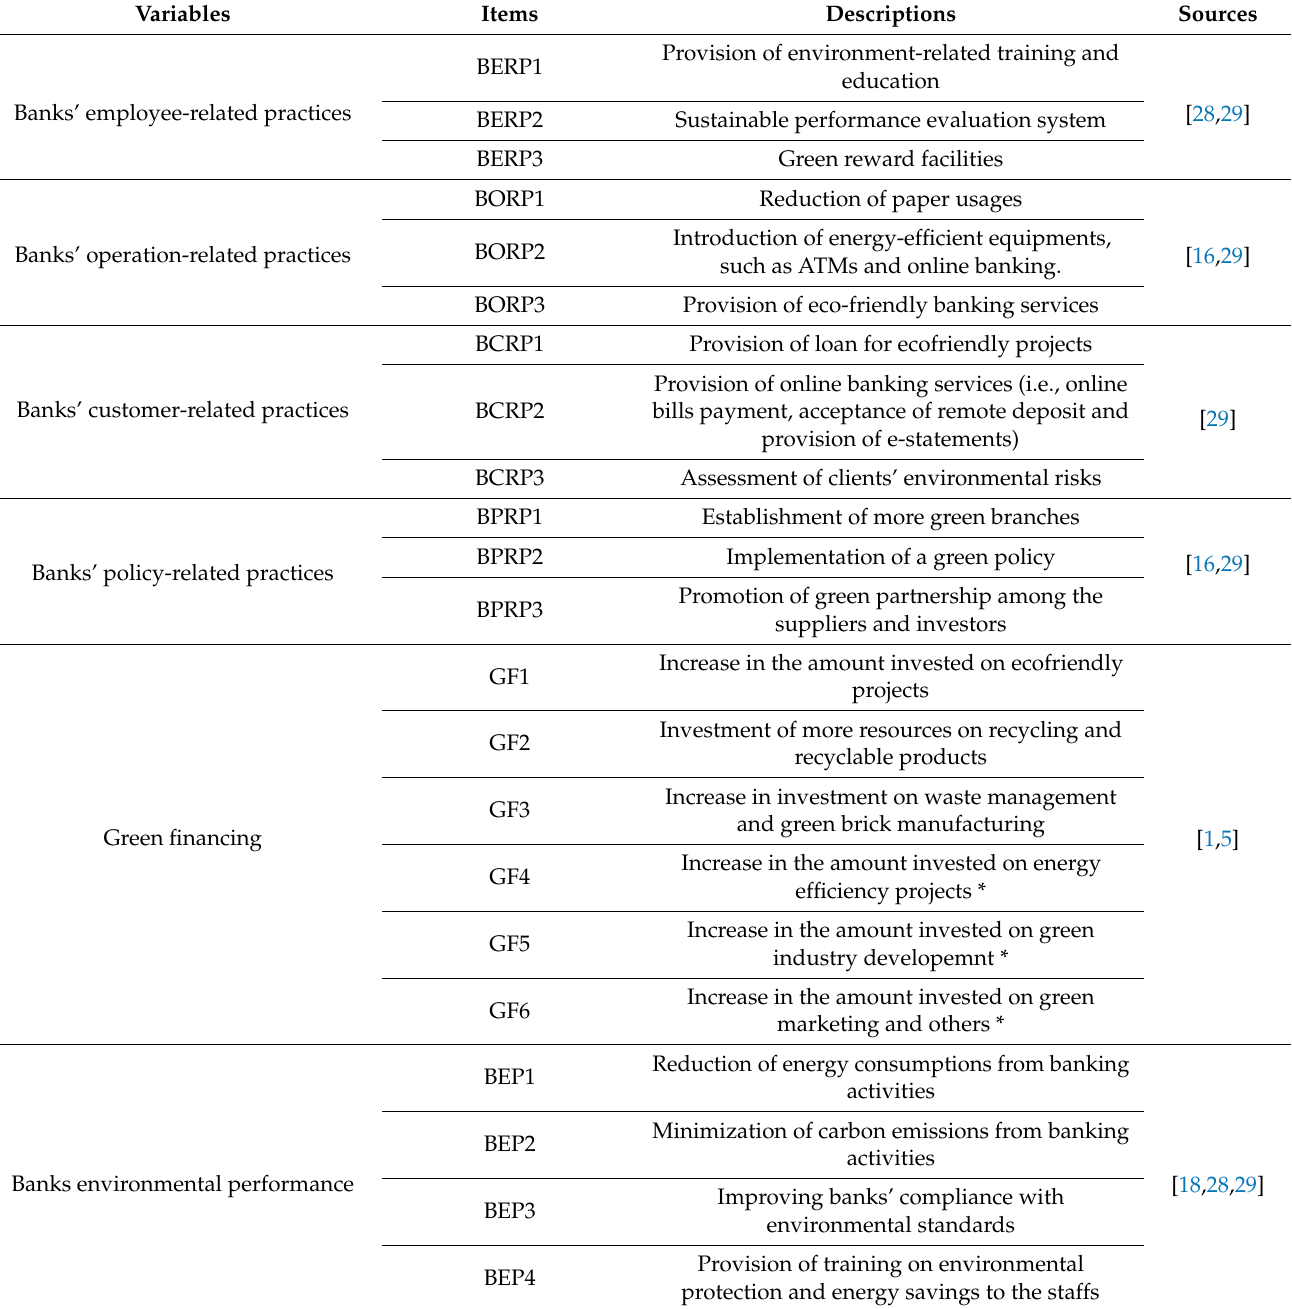
Table 2. Questionnaire